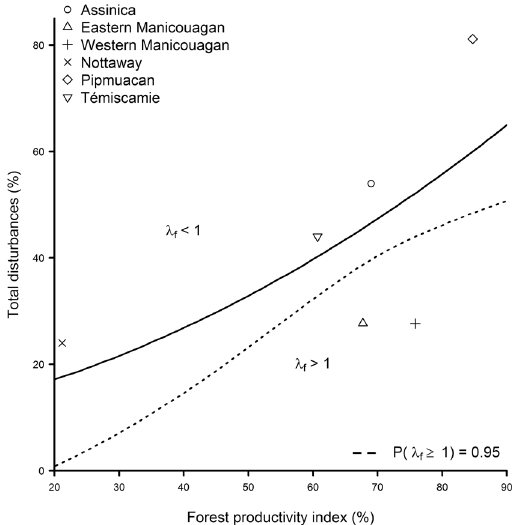
Figure 3. Combination of total disturbance (fire and logging) and the proportion of potentially productive stands (the forest productivity index) for which the annual rate of change in the female population ( λ f ) is equal to 1 (solid line), with the lower limit yielding λ f ≥ 1 at least 95% of the time. The population tends to increase ( λ f > 1) below the line and decline ( λ f < 1) above it. Symbols represent the combination for individual populations, with respect to the observed combination of disturbance during their last year of